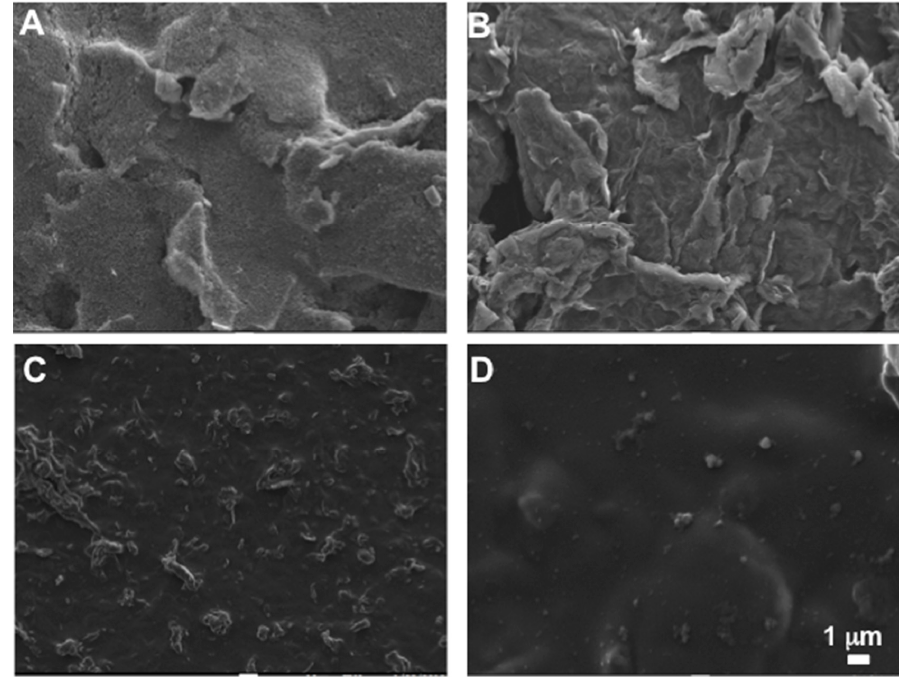
Figure 1. SEM images of: ( A ) bare screen-printed carbon electrode (SPCE), ( B ) reduced graphene oxide (rGO) /SPCE, ( C ) chitosan/rGO/SPCE, and ( D ) tyrosinase/chitosan/rGO/SPCE.